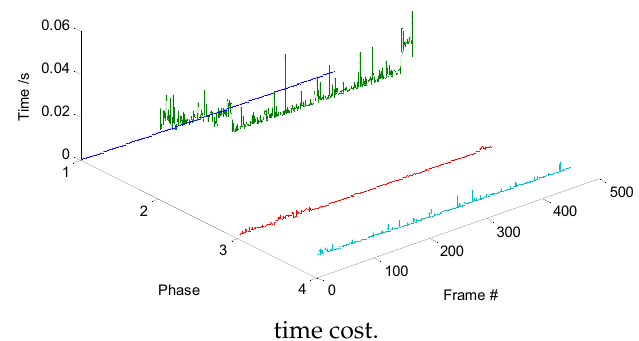
Figure 15. Distribution Field Tracker